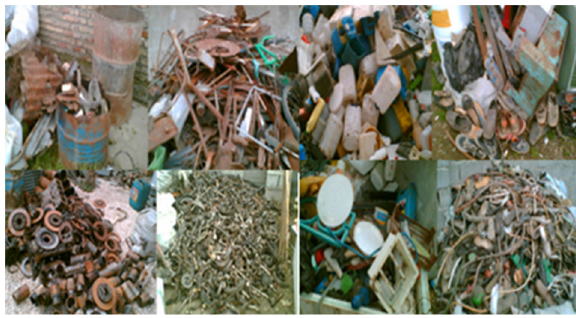
Fig. 2. Types of waste disassembled at recycling